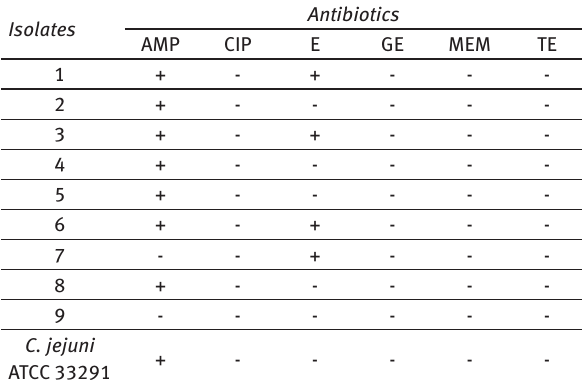
Table 4 Resistance of C. jejuni isolates to